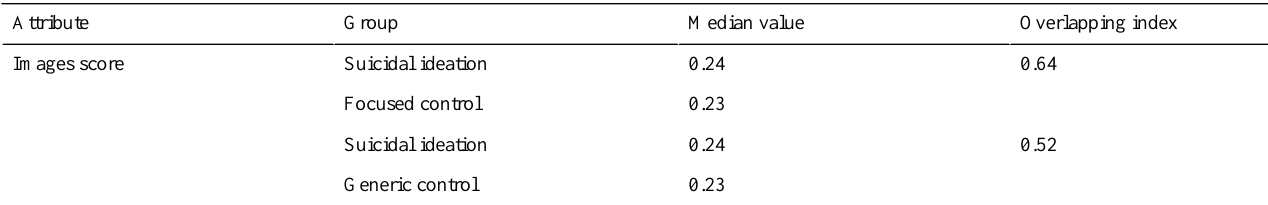
Table 8. Medians and Overlapping Index for the images score between the suicidal ideation, focused control and generic control classes.